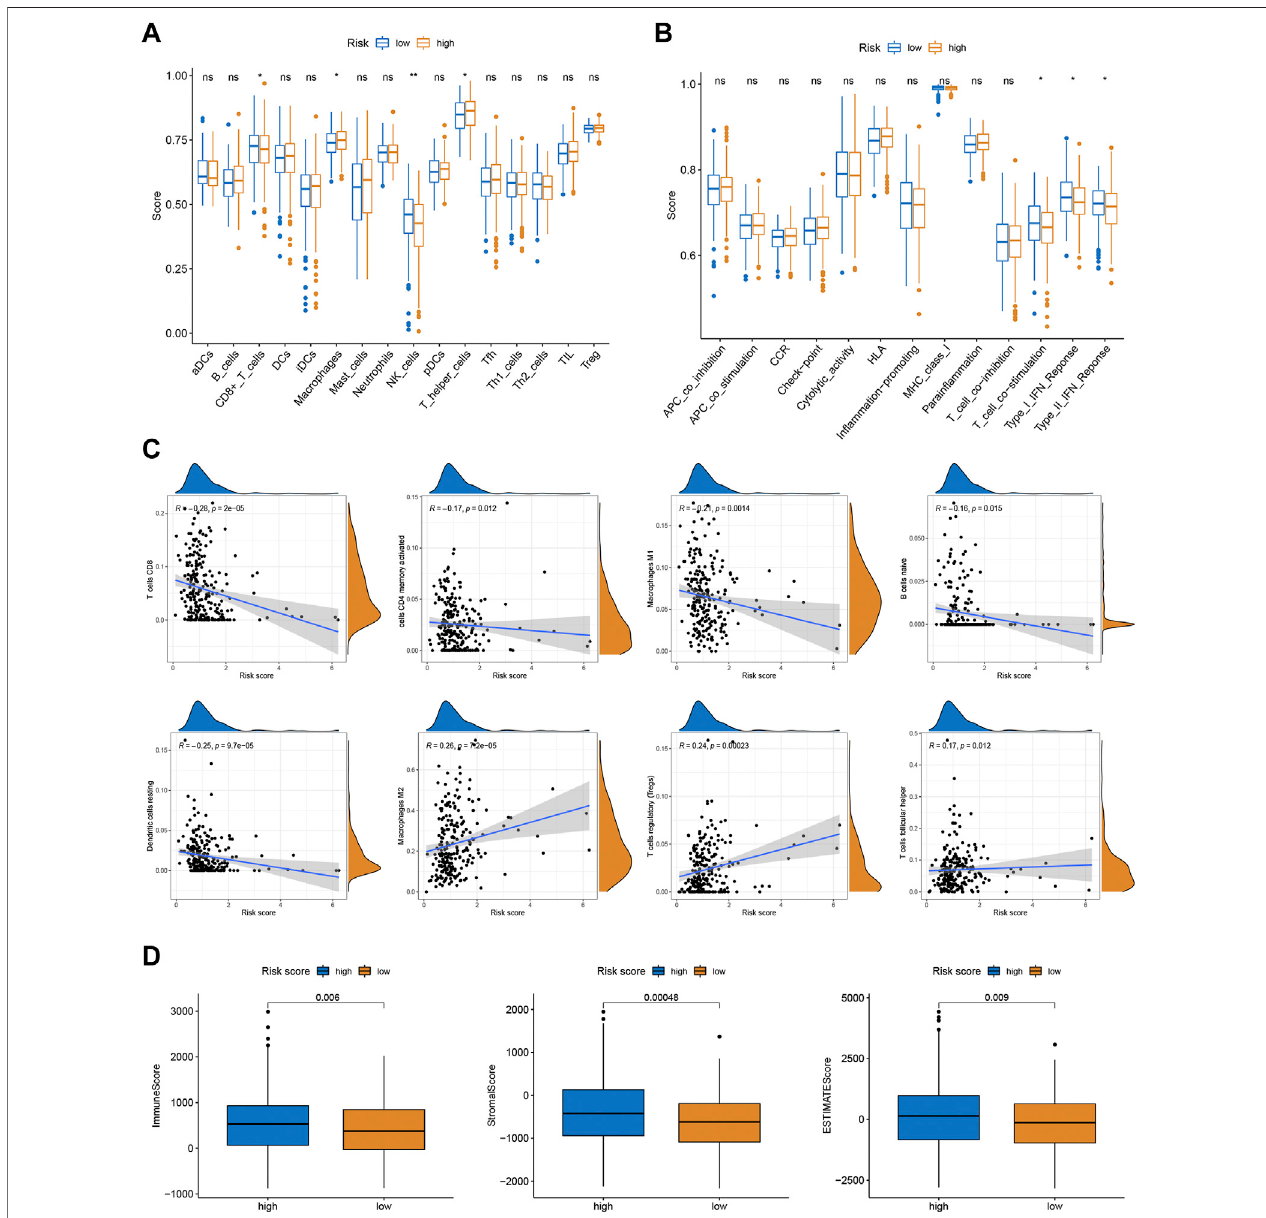
FIGURE 4 | Correlations between the risk scores and TME. (A) The ssGSEA scores of immune in fi ltrating cells. (B) The ssGSEA scores of immune functions. (C) The proportion of 22 immune in fi ltrating cells in two risk subgroups. (D) TME score in two risk subgroups.